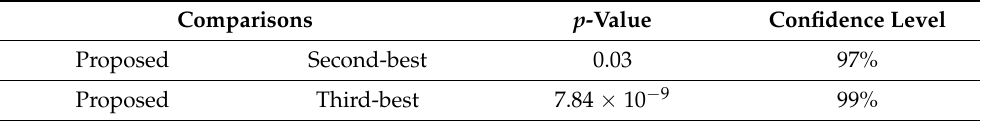
Table 14. The t -test analysis results between our model and the second-best and third-best models. Comparisons p -Value Confidence Level Proposed Second-best Proposed